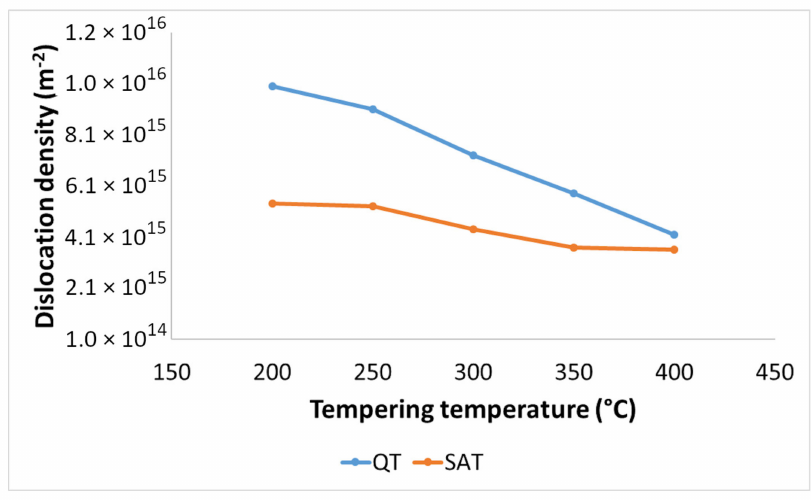
Figure 11. Dislocation density in QT and SAT samples tempered at different temperatures.